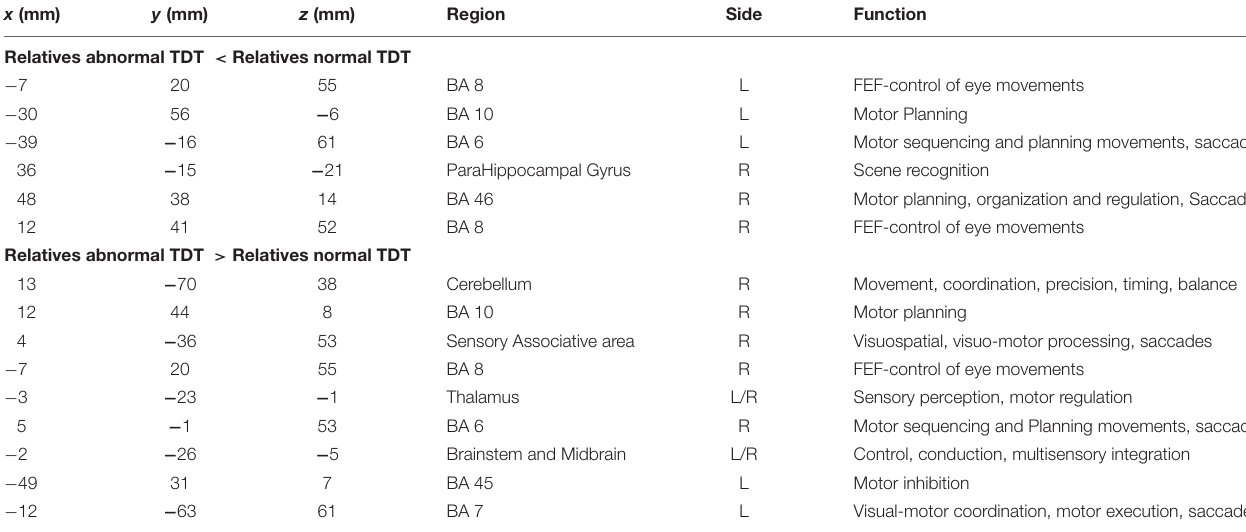
The columns denote the clusters’ x, y, z coordinates in mm, the area represented by them, side of the brain and function of the region. Clusters with voxel p < 0.005 and size > 534 mm 3 have been reported.